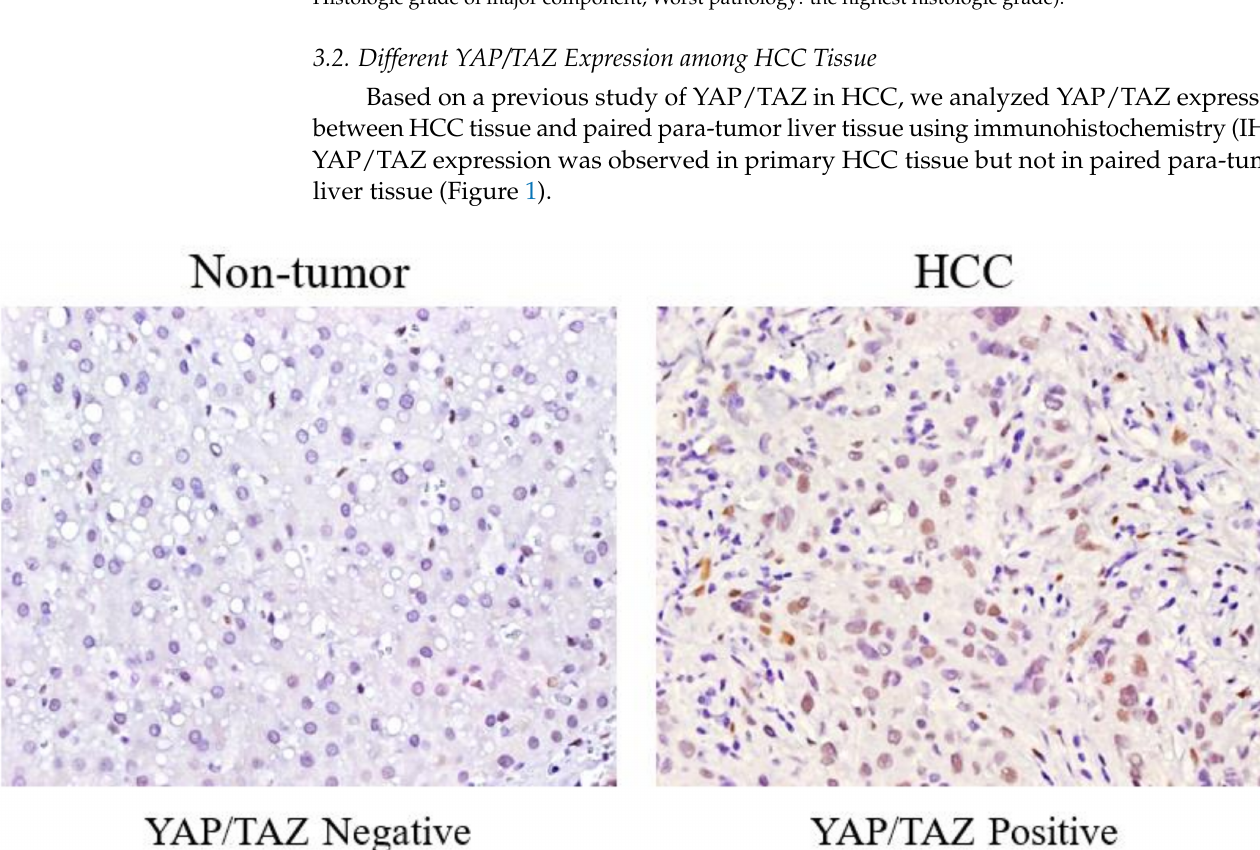
Figure 1. Comparison of YAP/TAZ expression between HCC and non-tumor using immunohisto- chemistry. Immunohistochemical expression of YAP/TAZ in tissues from HCC patients and adjacent nontumor tissues. Yellowish staining of nucleus demonstrates YAP/TAZ immunostaining, and this was shown as positive in tumor tissue. Adjacent nontumor tissue did not show YAP/TAZ immunostaining. Representative images were taken under a microscope ( ×